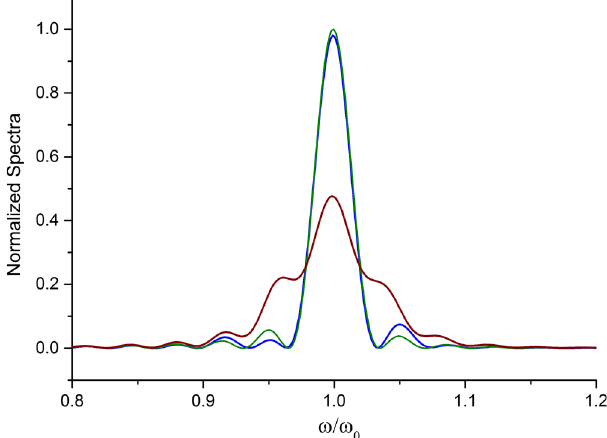
FIG. 14. Spectra of spontaneous emission at fundamental harmonic (green curve — undulator with ideal block positions, red — after one step of the period adjustment, blue — after 20 iterations).